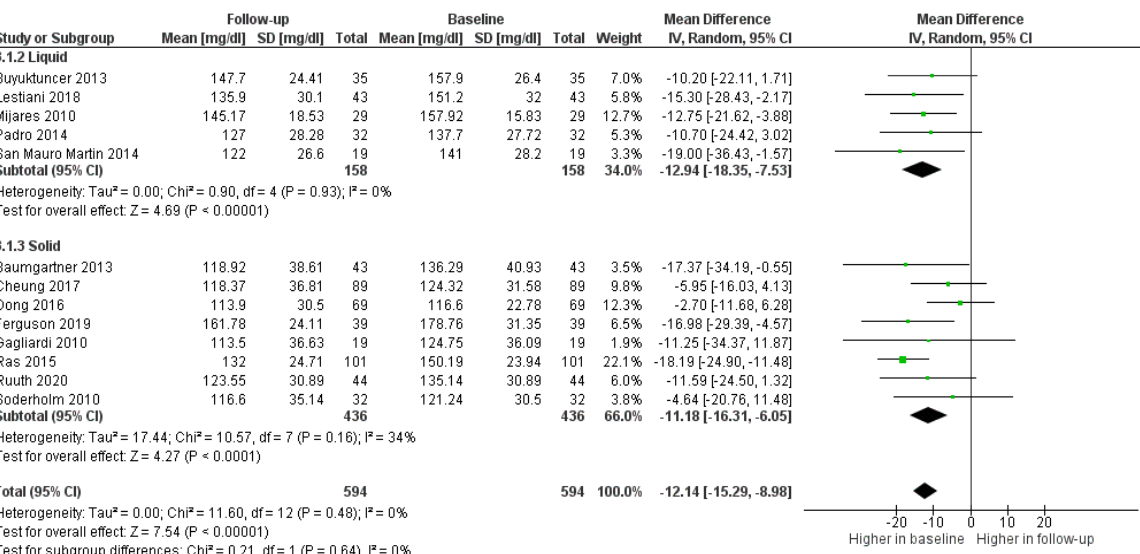
Figure 6. Forest plot comparing liquid or solid matrixes among participants in the treatment groups.